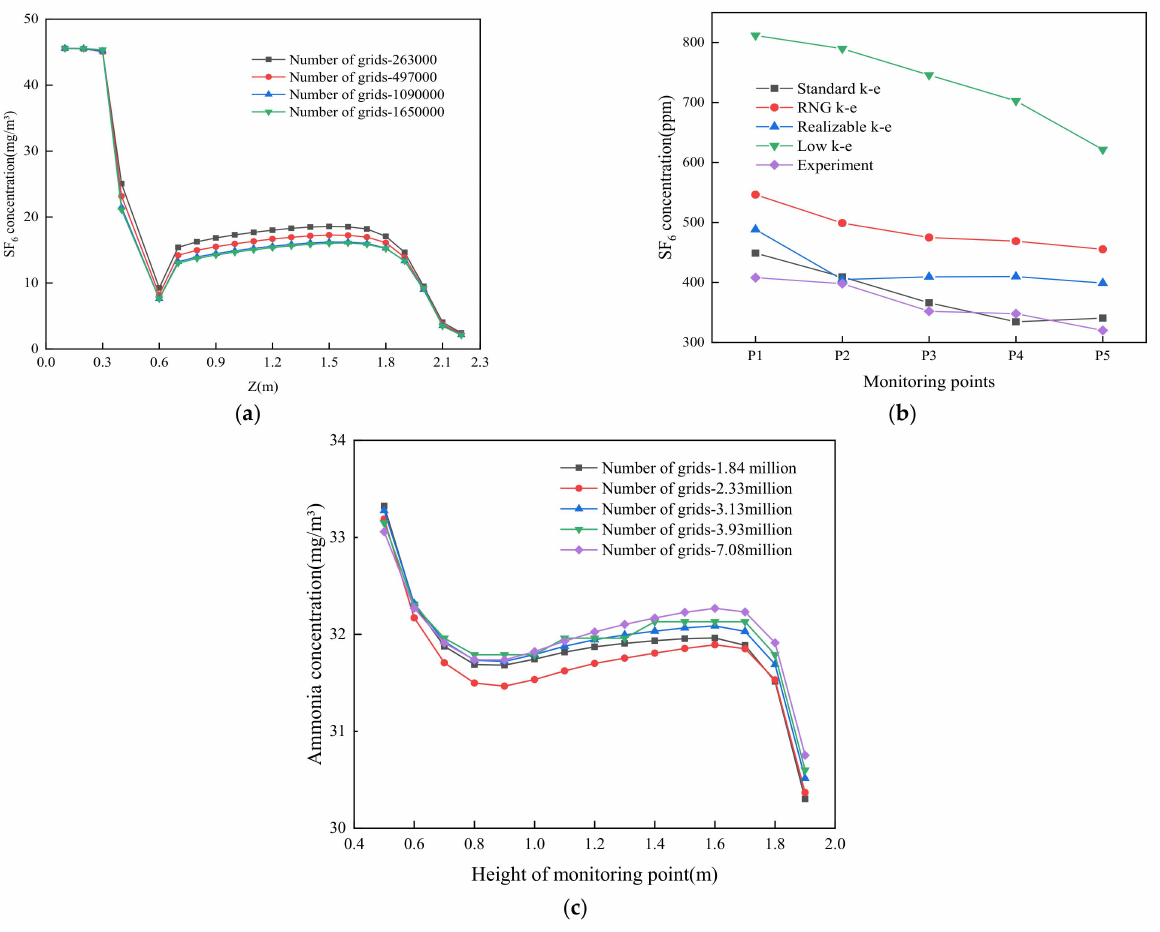
Figure 2. SF 6 and ammonia concentrations at different locations. ( a ) Grid independence verification (test bench). ( b ) Validation of the SF 6 concentration at different locations. ( c ) Grid independence verification (restroom